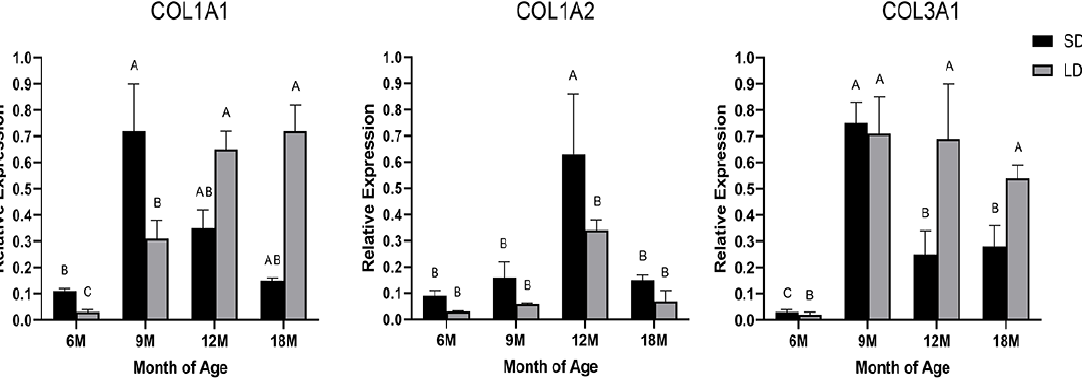
Figure 1. The mRNA abundance of ( COL1A1 , COL1A2 ), and ( COL3A1 ) in the semitendinosus (SD) and longissimus dorsi (LD) muscles at different growth stages. Different capital letters indicate significant differences between different months in the same muscle tissue.